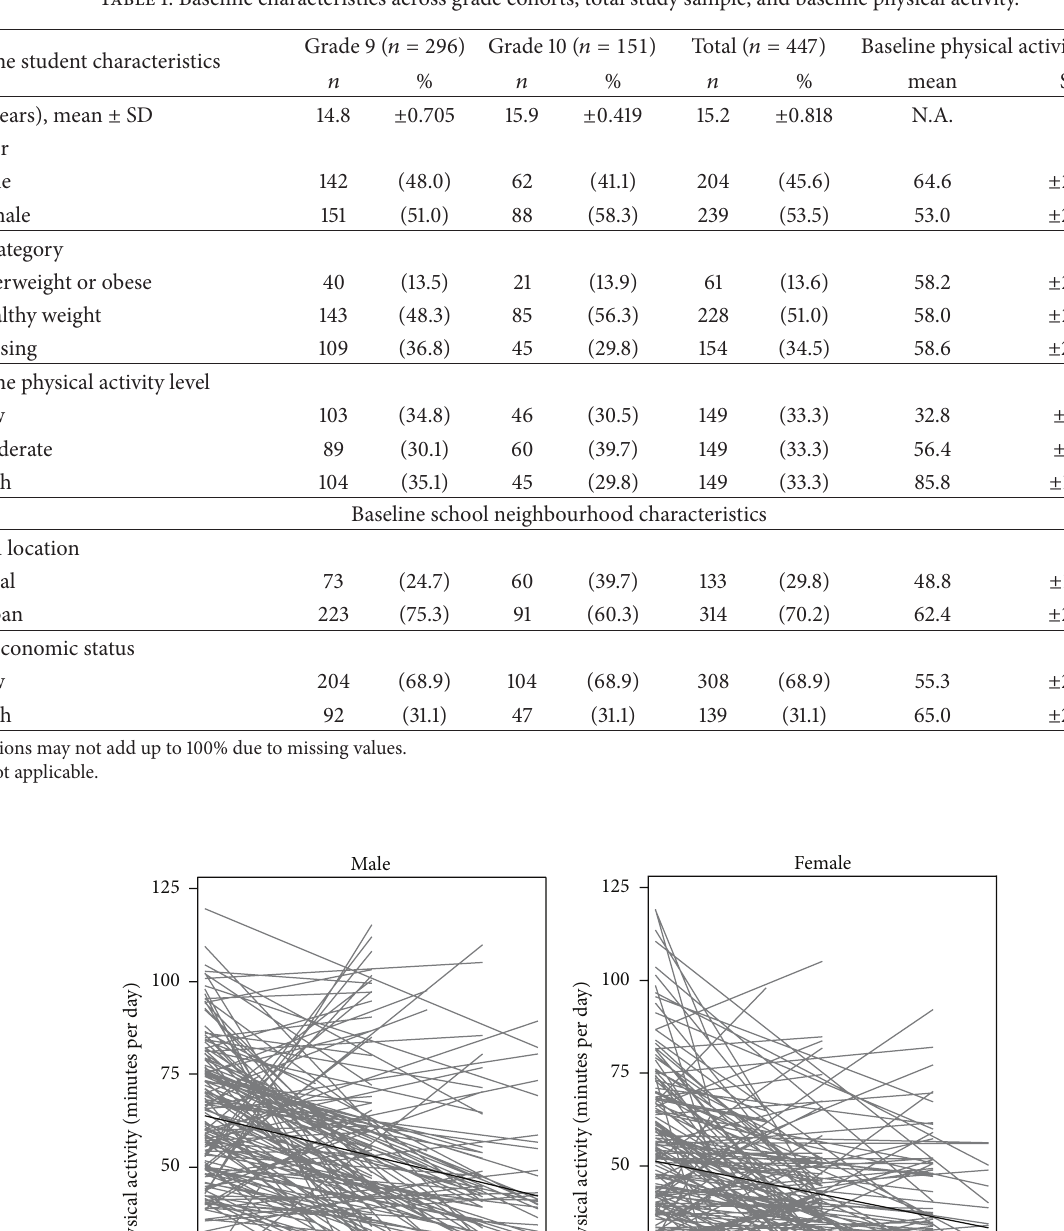
Table 1: Baseline characteristics across grade cohorts, total study sample, and baseline physical activity.